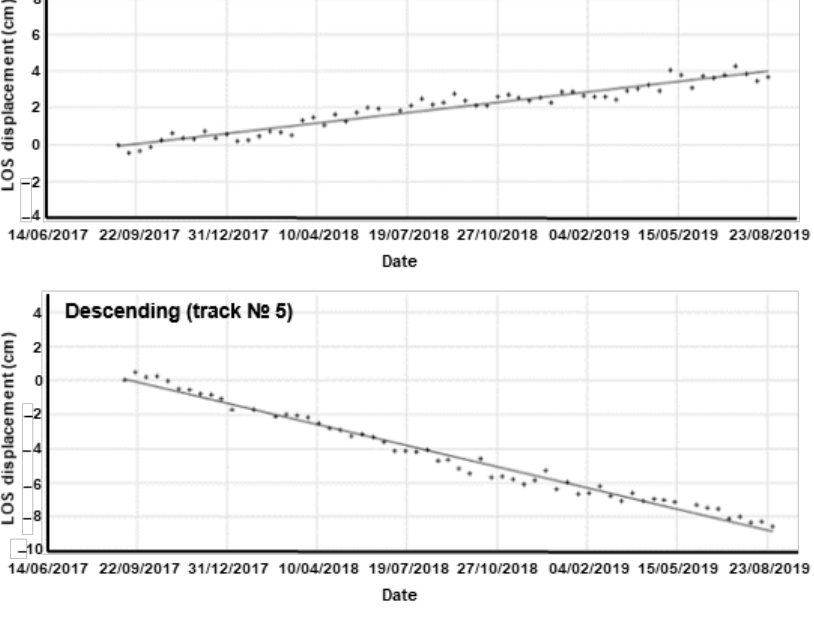
Figure 9. Time-series of ISBAS-derived cumulative LOS ground displacement for point B (indicated in Figure 6), the Usoy Dam.